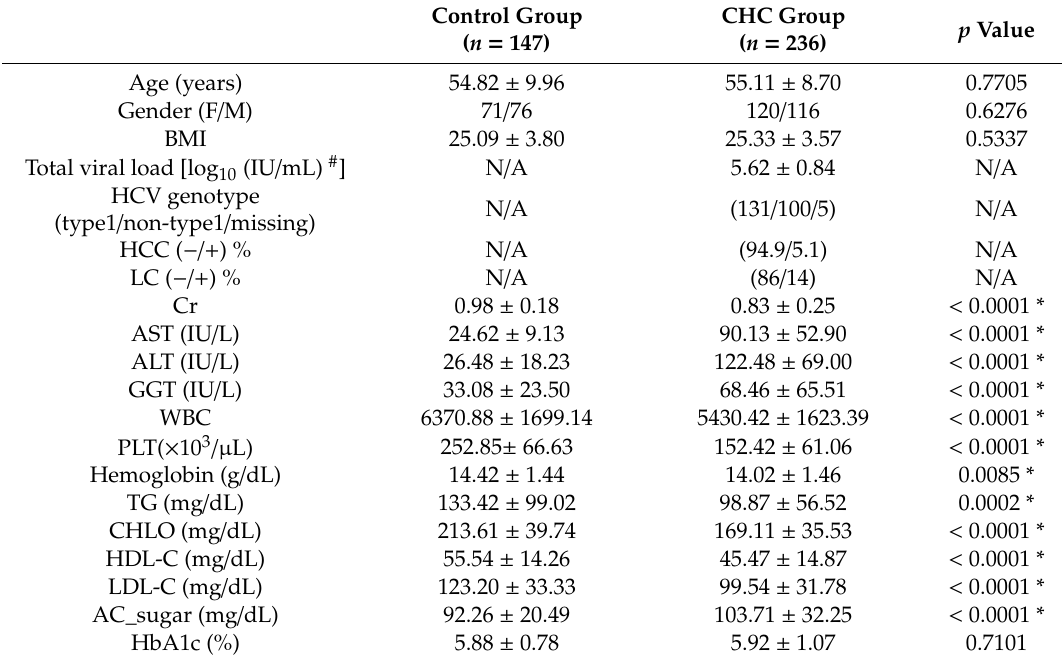
Table 1. Descriptive characteristics of baseline factors in study participants ( n = 383) 1